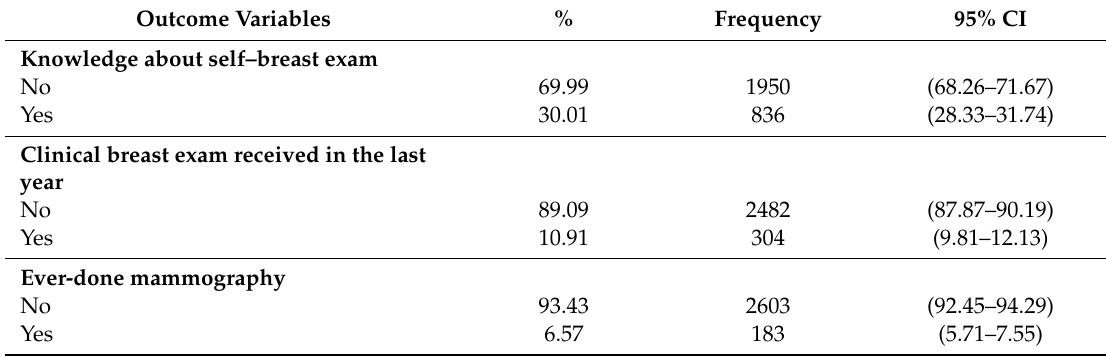
Table 1. Knowledge and uptake of breast cancer screening among Saudi women 35 + years old.